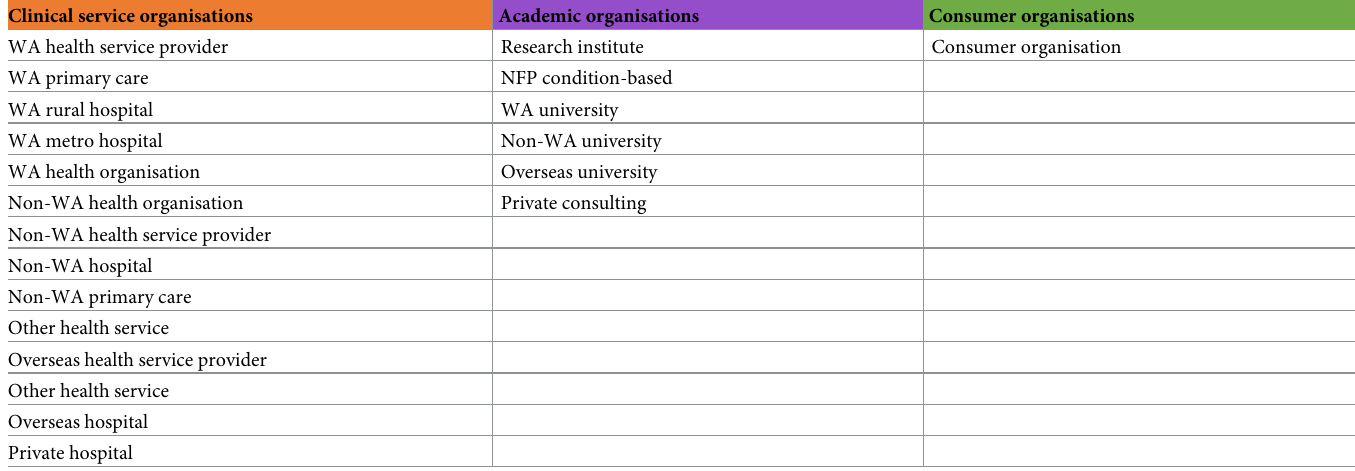
Table 2. Categories of participating